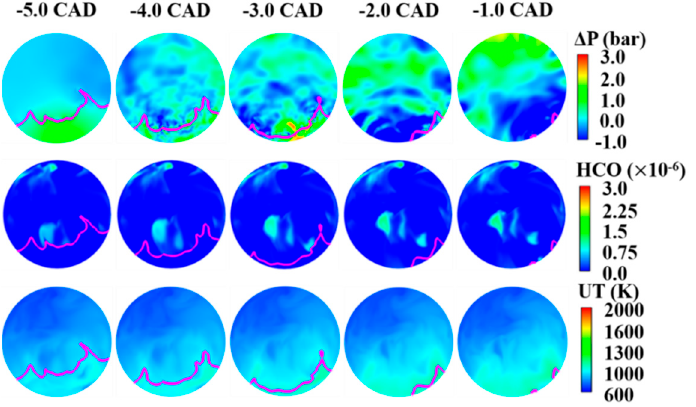
Figure 14. Evolution of ∆ P, mass fraction of HCO, and unburned temperature after the initial auto-ignition at ω = 0.8.